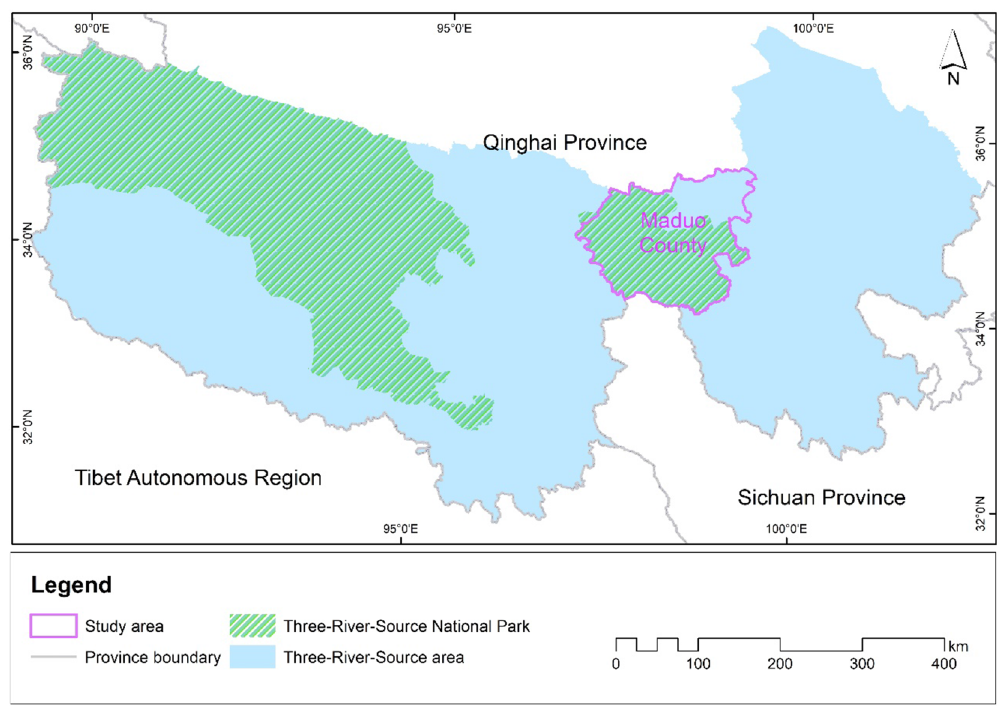
Figure 1. The spatial location of the study area, the Three-River-Source National Park and the Three-River- Source area. The map was generated using ArcGIS 10.2, https ://deskt op.arcgi